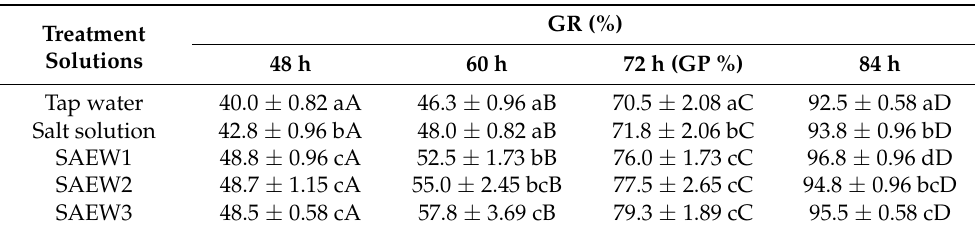
Table 3. Effects of different germination treatments on the germination rate and germination potential of foxtail millet 1 .